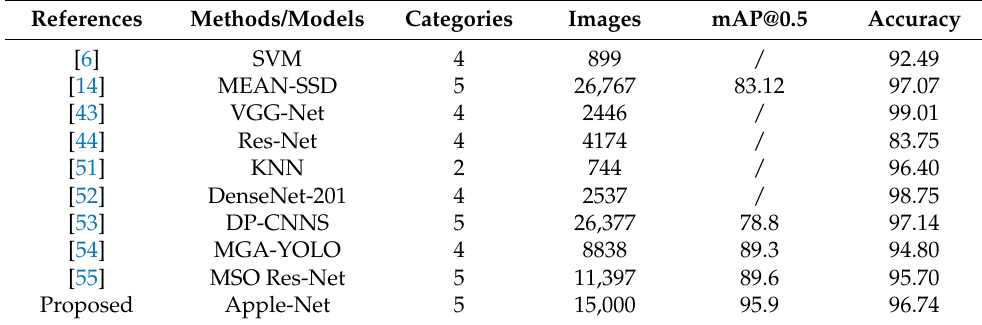
Table 4. Comparison with existing methods for apple disease